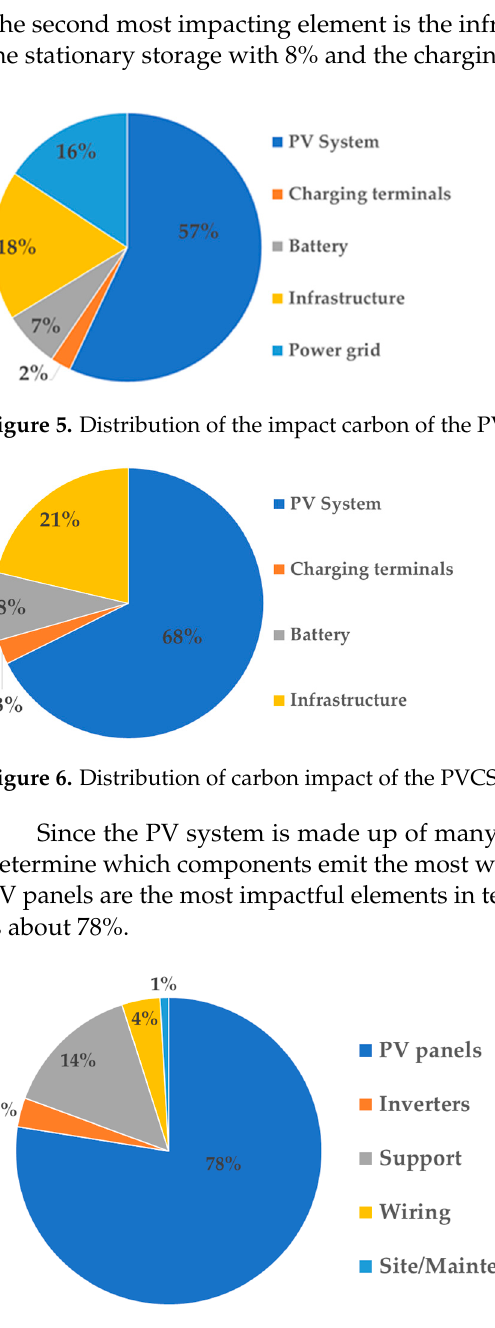
Figure 7. Distribution of carbon impact of the PV